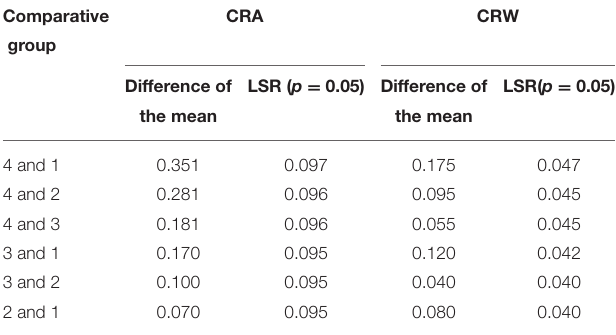
TABLE 3 | Dunnett’s post-hoc test of CRA and CRW for the 4 cases of breathing: free breathing (1), and 3 paced breathing at frequency of 0.33Hz (2), 0.26Hz (3), and 0.12Hz